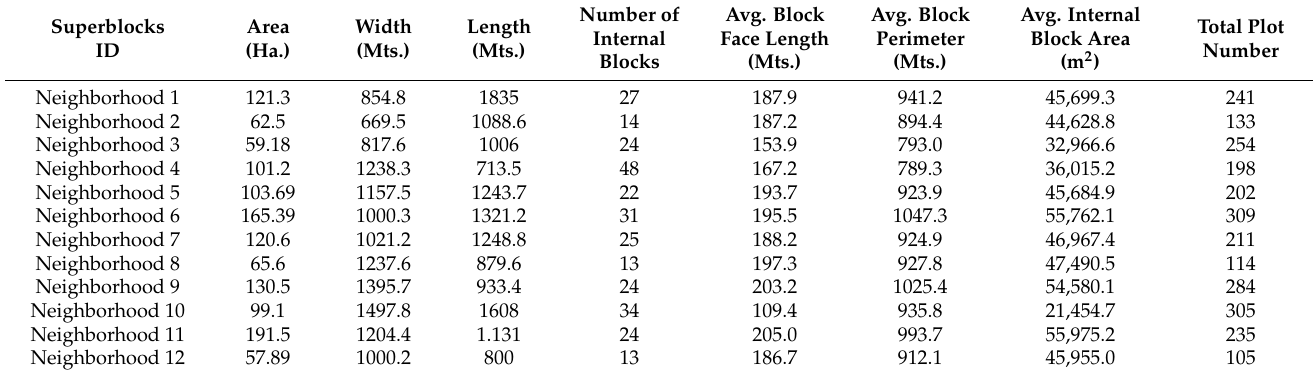
Table 1. Descriptive statistics of the all-residential-plots-to-all-residential-plots route directness analysis. Superblocks ID